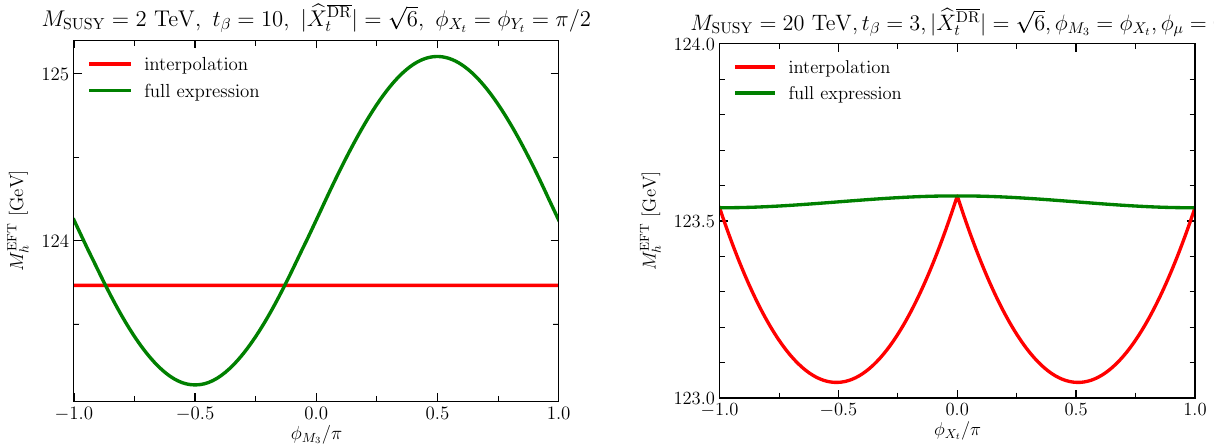
= φ = π/ 2. Right: M Y t t